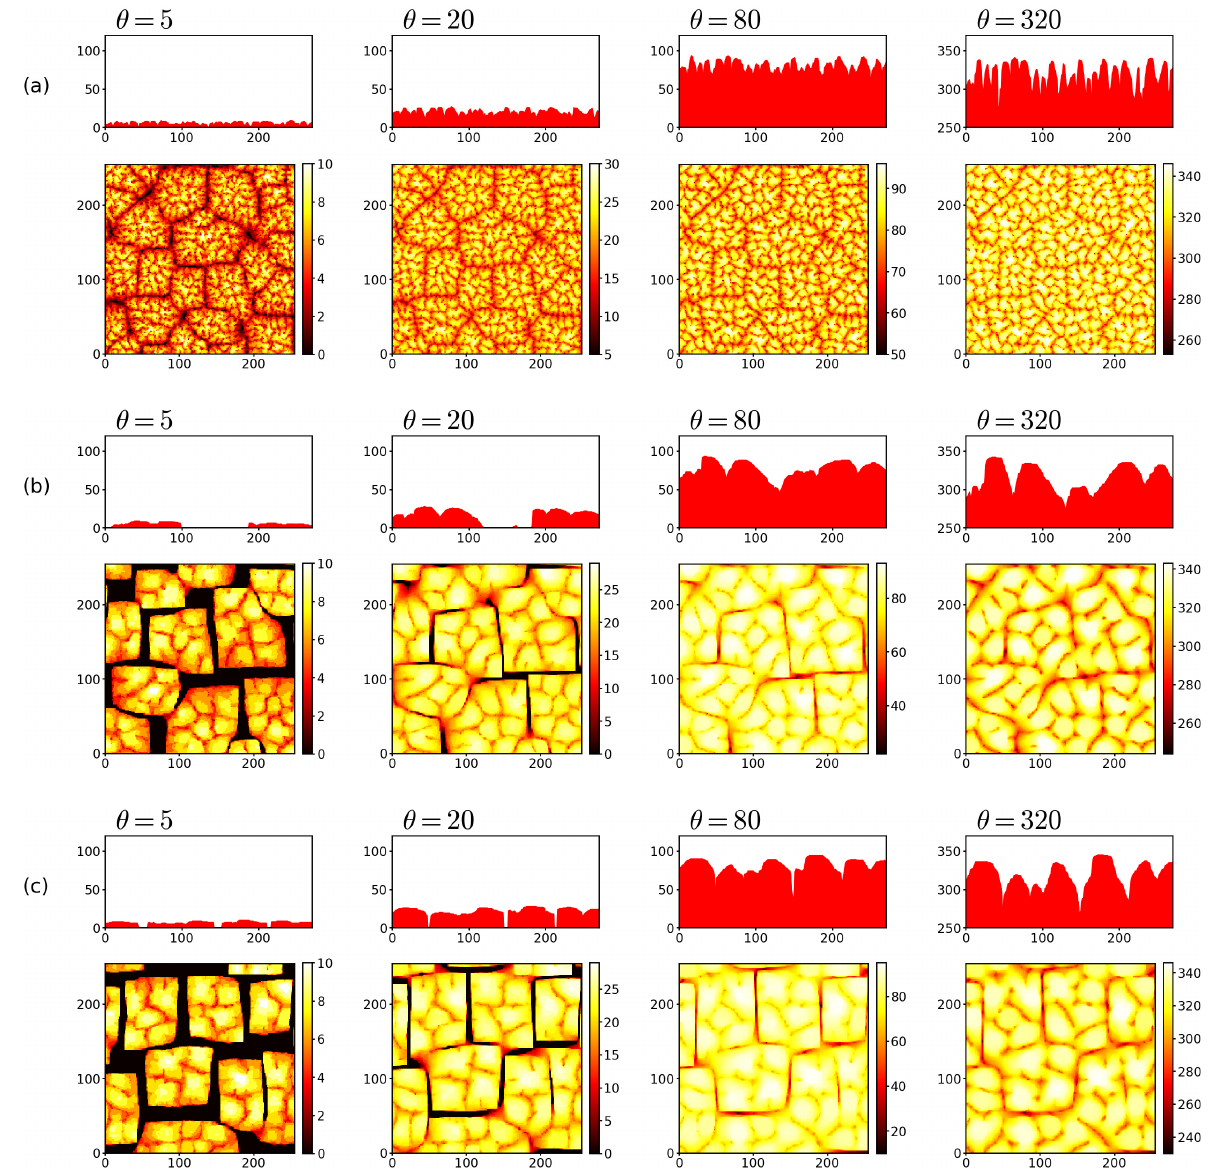
Figure 4. Vertical cross-sections and top views of parts of the deposits grown in simulations with ES barriers. Parameter sets were ( a ) D, ( b ) D2, and ( c ) D3. Cross-sections were not in scale and some were restricted to the upper layers. All lengths are in units of the lattice constant.